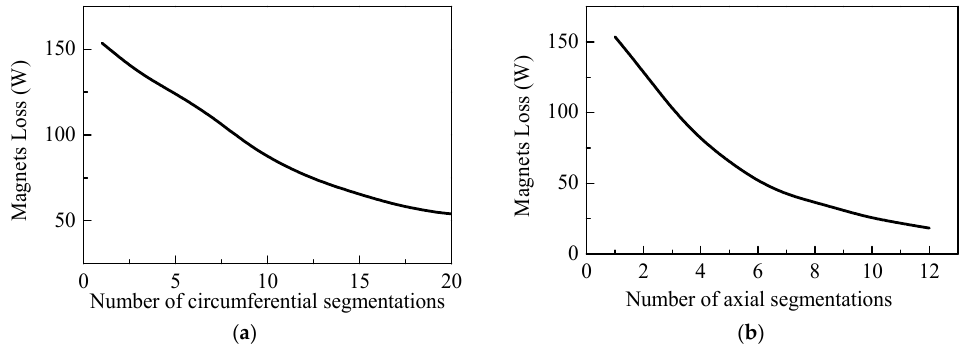
Figure 6. ( a ) Eddy-current losses of magnets versus circumferential segmentation number; ( b ) eddy- current losses of magnets versus axial segmentation number.